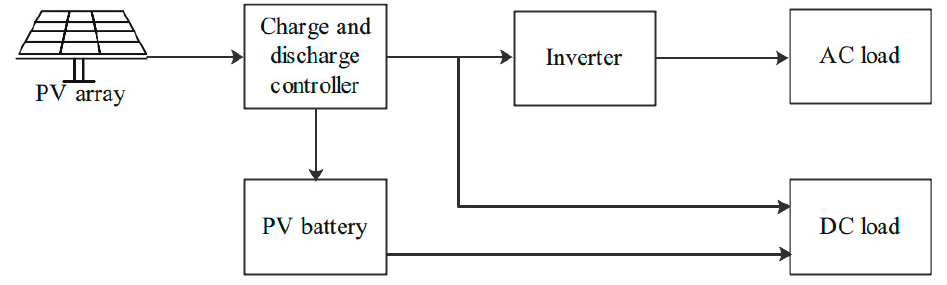
Figure 6. Structural diagram of photovoltaic power generation system.